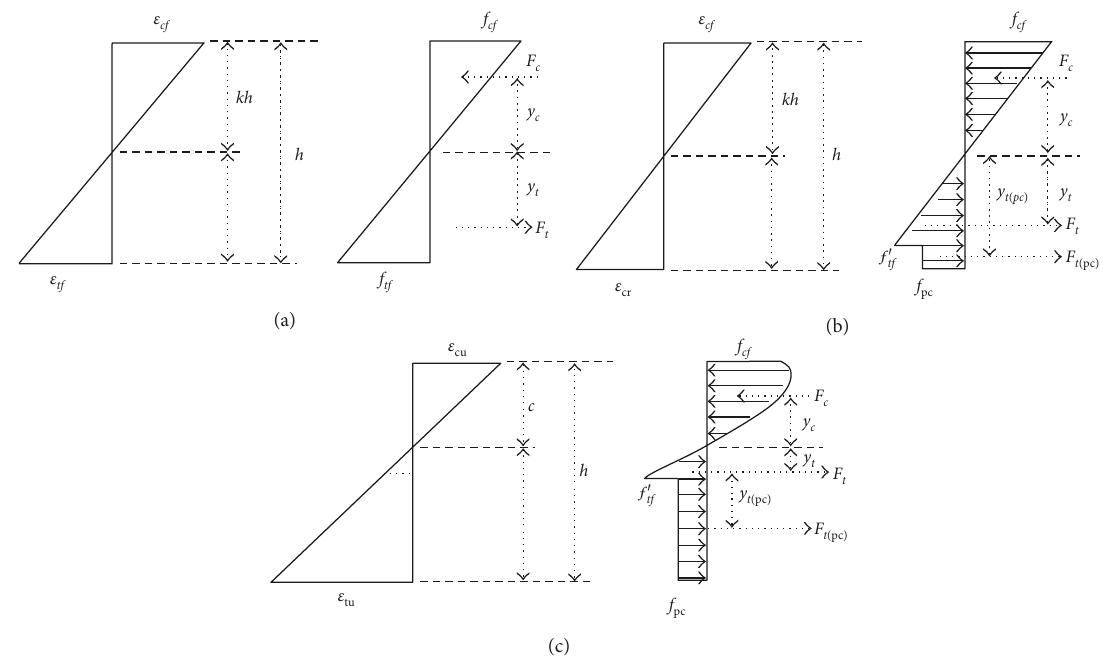
Figure 4: Three stages of stress-strain response in flexure. (a) Stage I: elastic behaviour in compression and tension. (b) Stage II: elastic behaviour in compression and plastic behaviour in tension (cracking stage). (c) Stage III: nonlinear behaviour in compression and plastic behaviour in tension (ultimate stage).